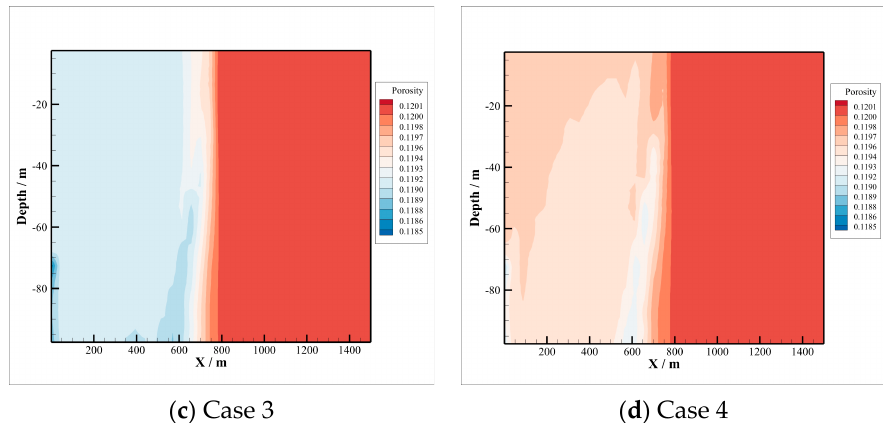
Figure 20. Porosity variations in different cases.